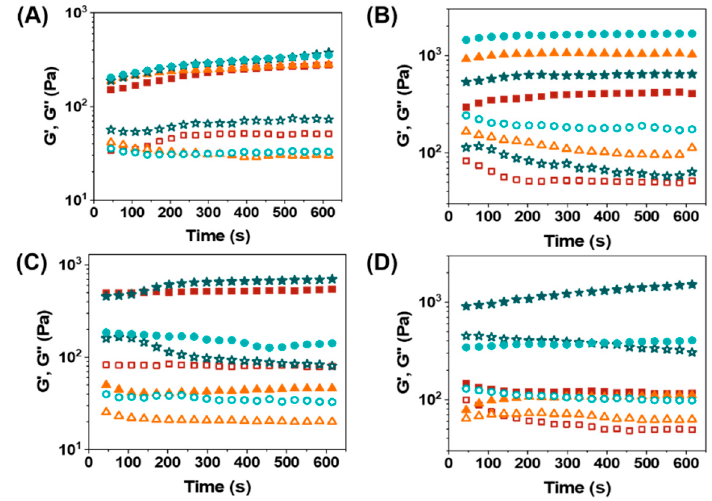
Figure 2. Variation of storage modulus (G’) and loss modulus (G ″ ) for oleogels formed by L -lysine-